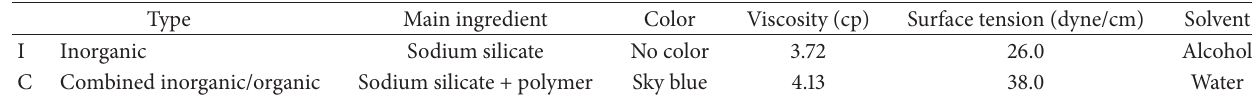
Figure 2: Durability improvement in surface-impregnated concrete. Table 1: Characteristics of applied surface